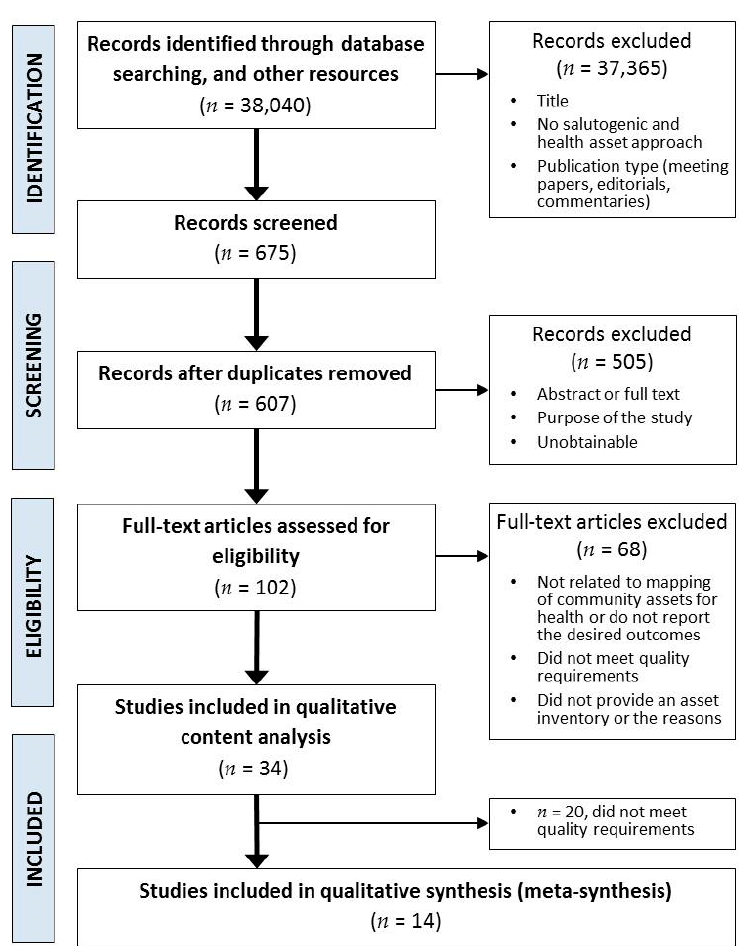
Figure 1. Adapted PRISMA flow diagram of the study selection